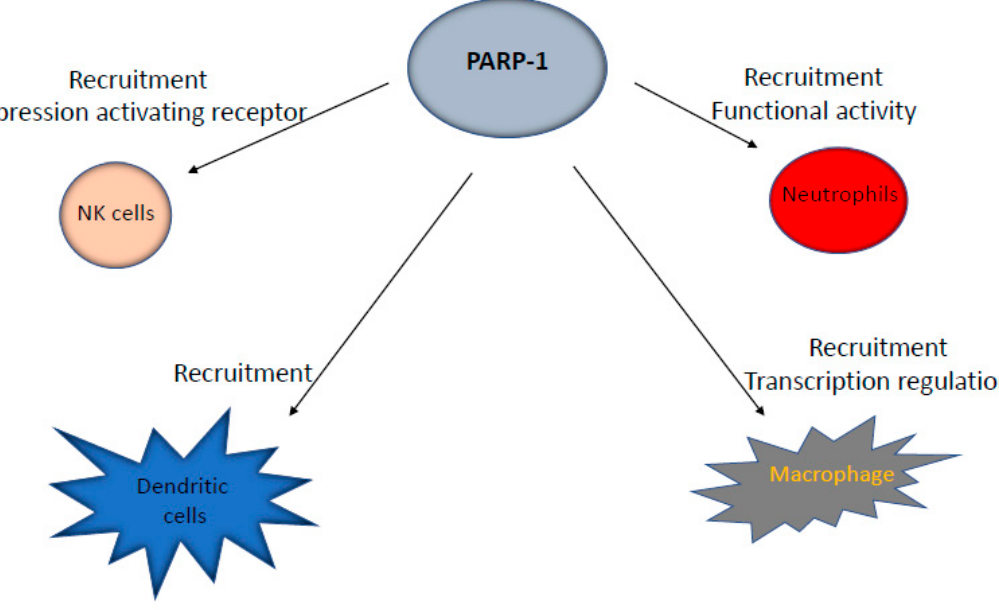
Figure 3. Schematic representation of the role played by PARP-1 in cells of the innate immune system. Macrophages are differentiated from circulating monocytes after extravasation into tissues.